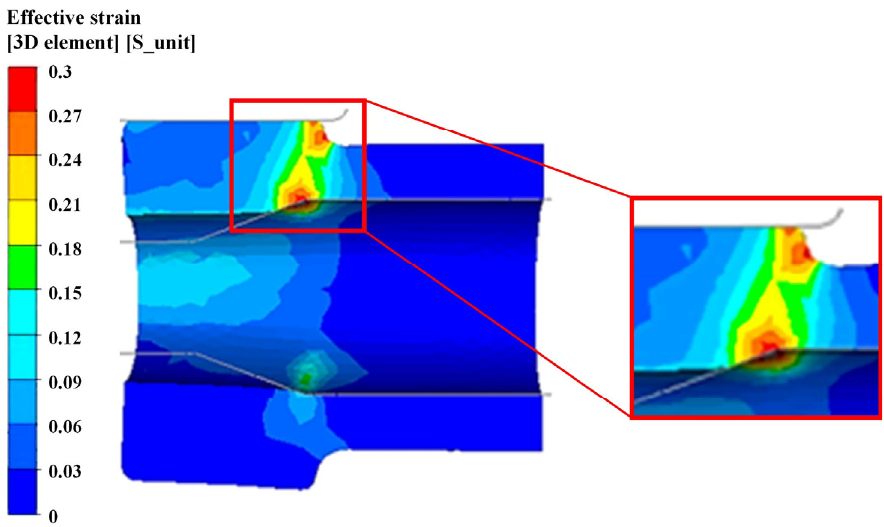
Figure 8. Effective strain distribution of single-step pressing on the longitudinal section.